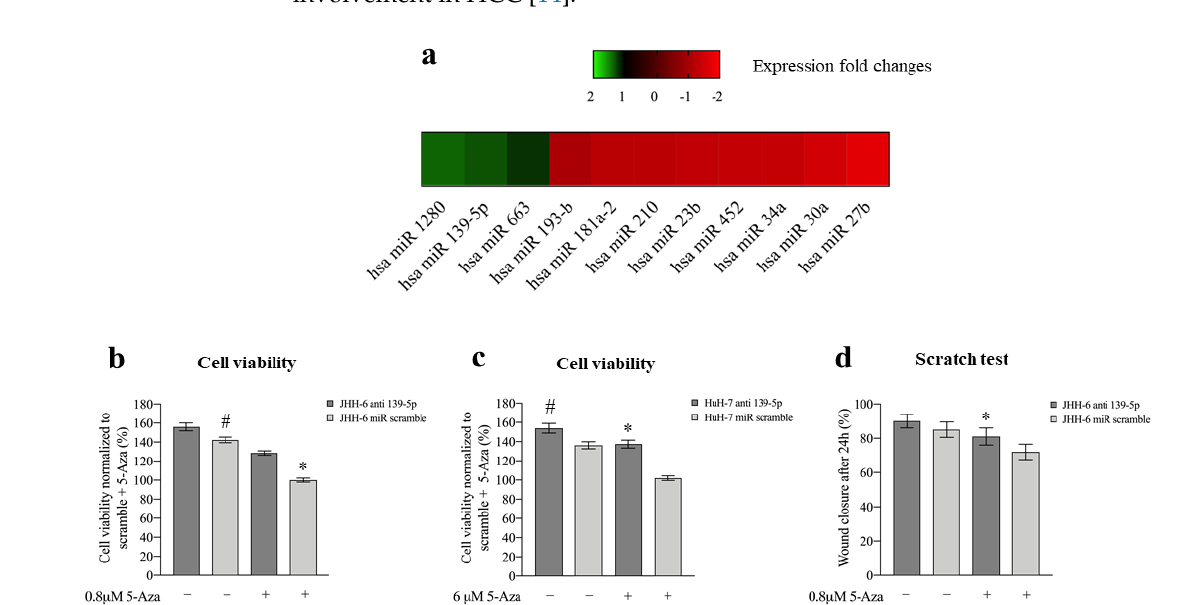
Figure 3. Effects of 5-Aza on miR expression and effects of miR-139-5p on cell viability and migration. ( a ) Differentially expressed miRs following 6 µ M 5-Aza treatments in JHH-6 evaluated by microarray analysis. ( b ) Viability of JHH-6 treated with both antagomiR-139-5p (100 nM) and 5-Aza. Data, normalized to the average of JHH-6 scr + 5-Aza, are represented as mean ± SEM, n = 3; JHH-6 antagomiR-139-5p vs. JHH-6 scr, # p = 0.0123; JHH-6 antagomiR-139-5p + 5-Aza vs. JHH-6 scr + 5-Aza, * p = 0.0001. ( c ) Viability of HuH-7 treated by both antagomiR-139-5p and 5-Aza. Data, normalized to the average of HuH-7 scr + 5-Aza, are represented as mean ± SEM, n = 3. HuH-7 antagomiR-139-5p vs. HuH-7 scr, # p = 0.0065; HuH-7 antagomiR-139-5p + 5-Aza vs. HuH-7 scr + 5-Aza, * p = 0.0001. ( d ) Migration of JHH-6 treated with both antagomiR-139-5p and 5-Aza. JHH-6 antagomiR-139-5p + 5-Aza vs. JHH-6 miR scr + 5-Aza, * p = 0.002. Data are presented as mean ± SEM, n = 3.